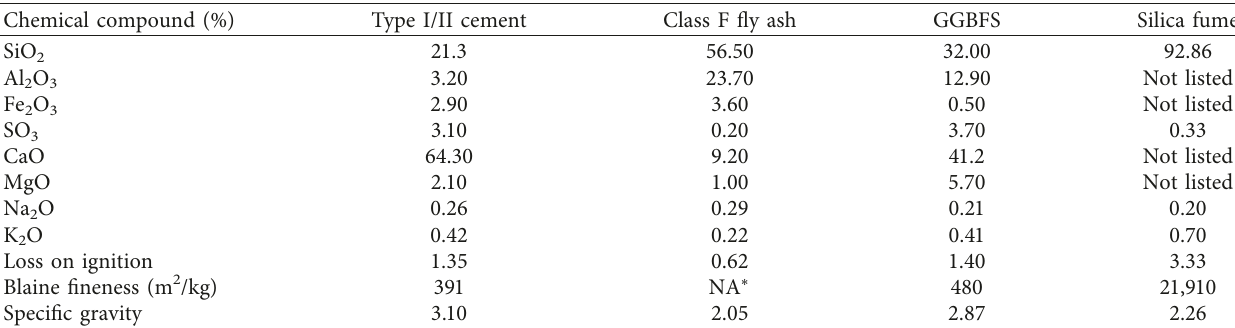
Table 2: Chemical composition of the cement and SCM based on manufacturer’s mill cert.